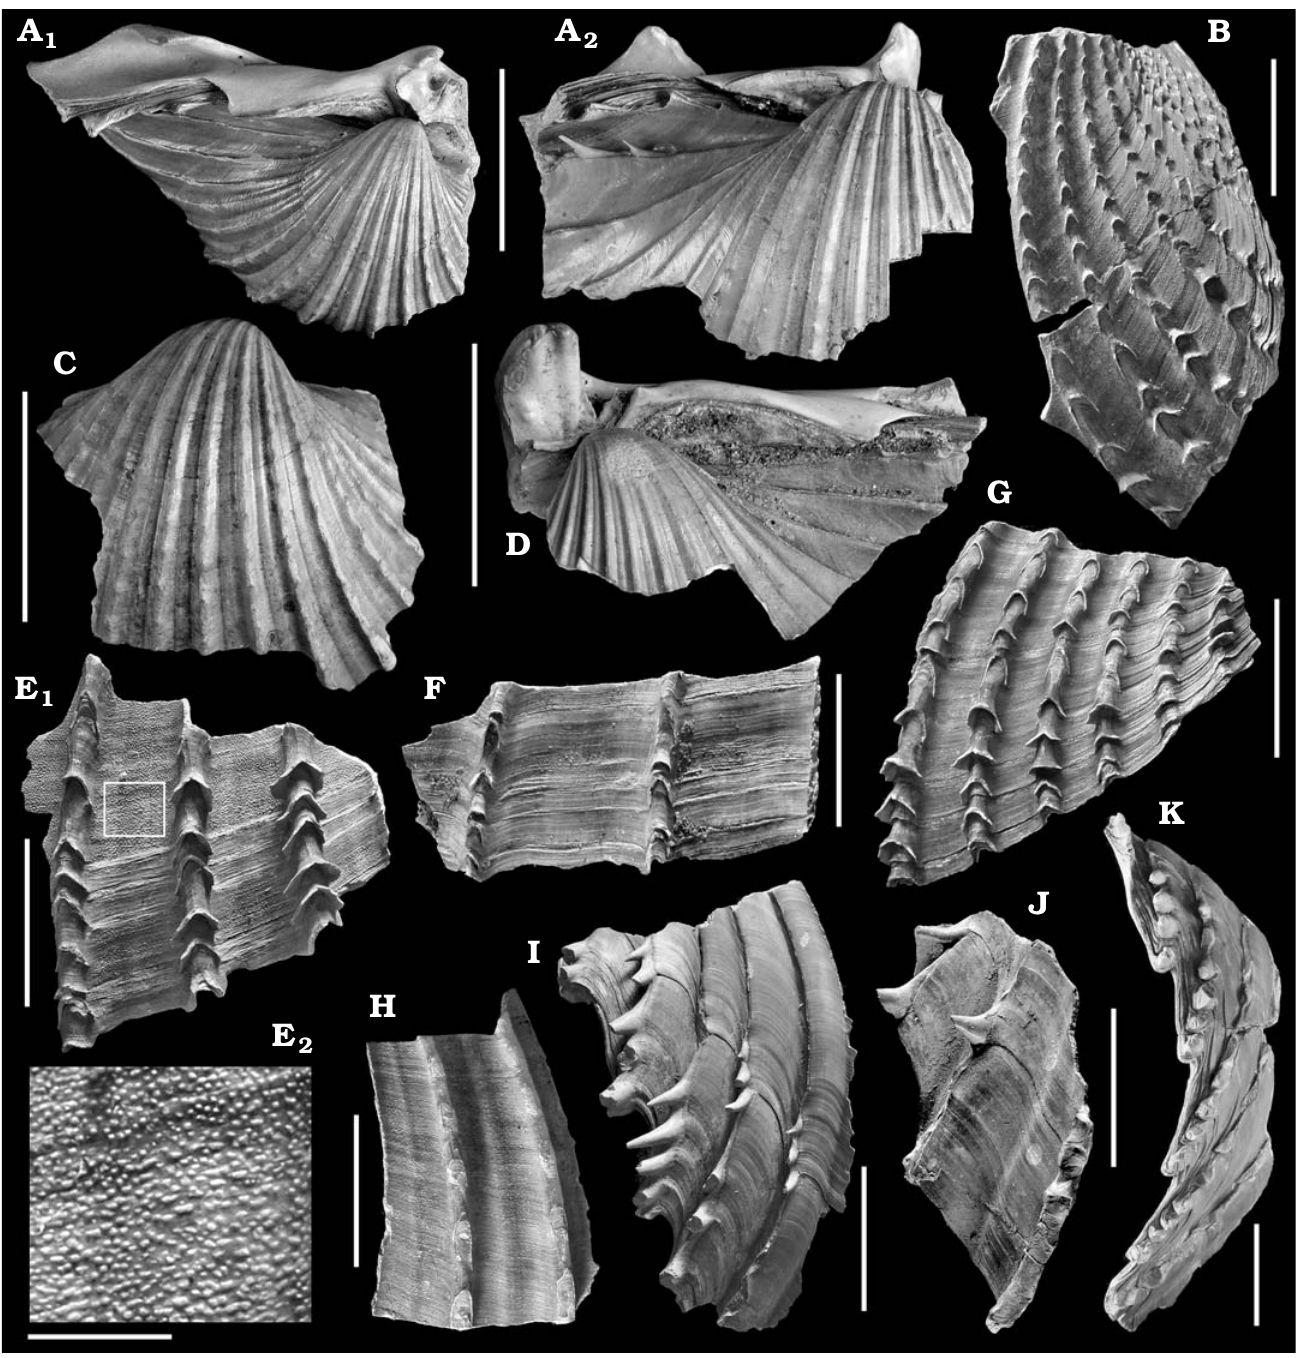
Fig. 13. Cardiid bivalve Procardium jansseni sp. nov. from Langhian (Miocene) of Winterswijk, Miste (except F that is from Limburg, Beringe, borehole Beeringen DB15 [B58B008]), The Netherlands. A . Holotype, RGM.1309269 (van der Voort collection), umbonal fragment. B . Paratype, RGM.225756, anterior fragment. C . RGM.1309415 (van der Voort collection), umbonal fragment, hinge missing. D . RGM.1309416 (van der Voort collection), umbonal fragment. E . Paratype, RGM.225755, anterior fragment (E 1 ) and detail of microsculpture (E 2 ). F . RGM.794094 (Rijks Geologische Dienst collection), median fragment. G . RGM.1309417 (van der Voort collection), anterior fragment. H . RGM.794092.a, median fragment. I . Paratype, RGM.225754, posterior fragment. J. RGM.1309991 (ter Poorten collection), posterior fragment. K . RGM.1309418 (van der Voort collection), posterior fragment. Scale bars: A–D, E 2 , F–K 10 mm; E 1 , 5